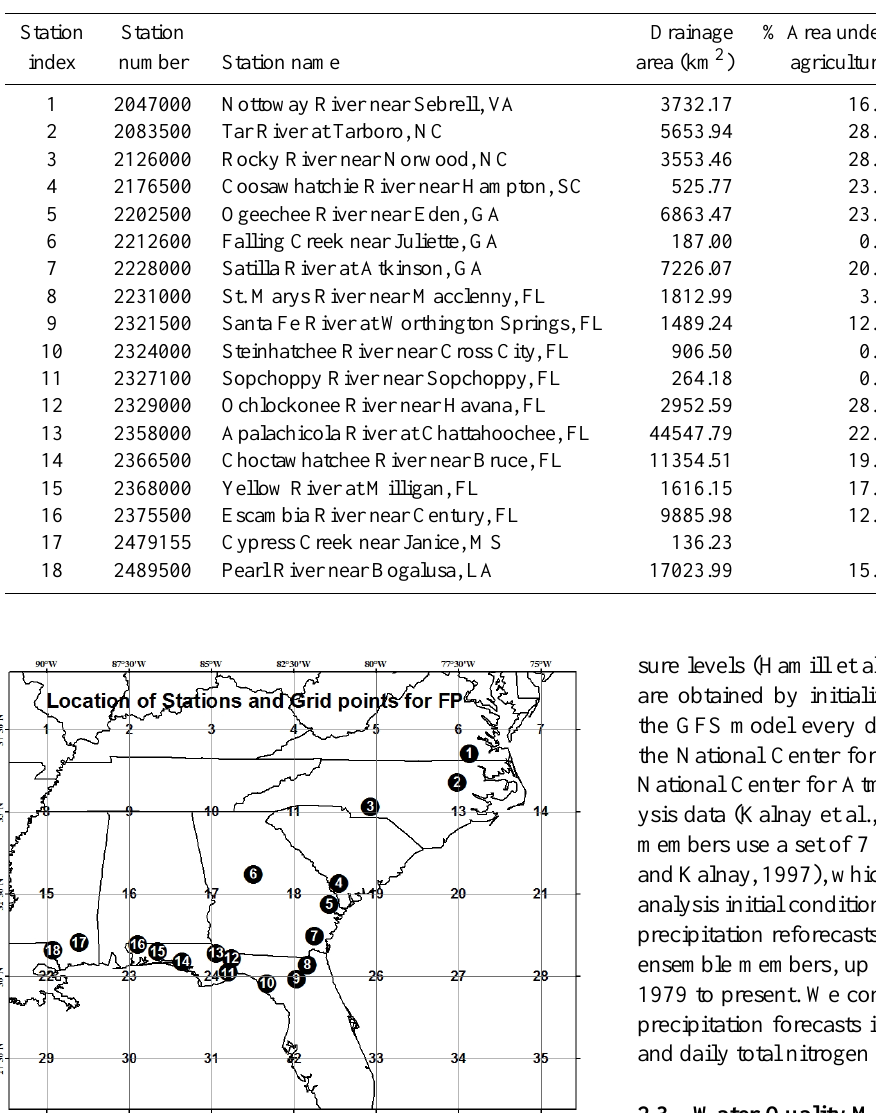
Table 1. Baseline information for the 18 selected stations. Percentage land use area under urban and agriculture are calculated based on the 2001 USGS NLCD data. Values in the parentheses in the last column show the total number of daily total nitrogen loadings and concentration samplings available for each station.